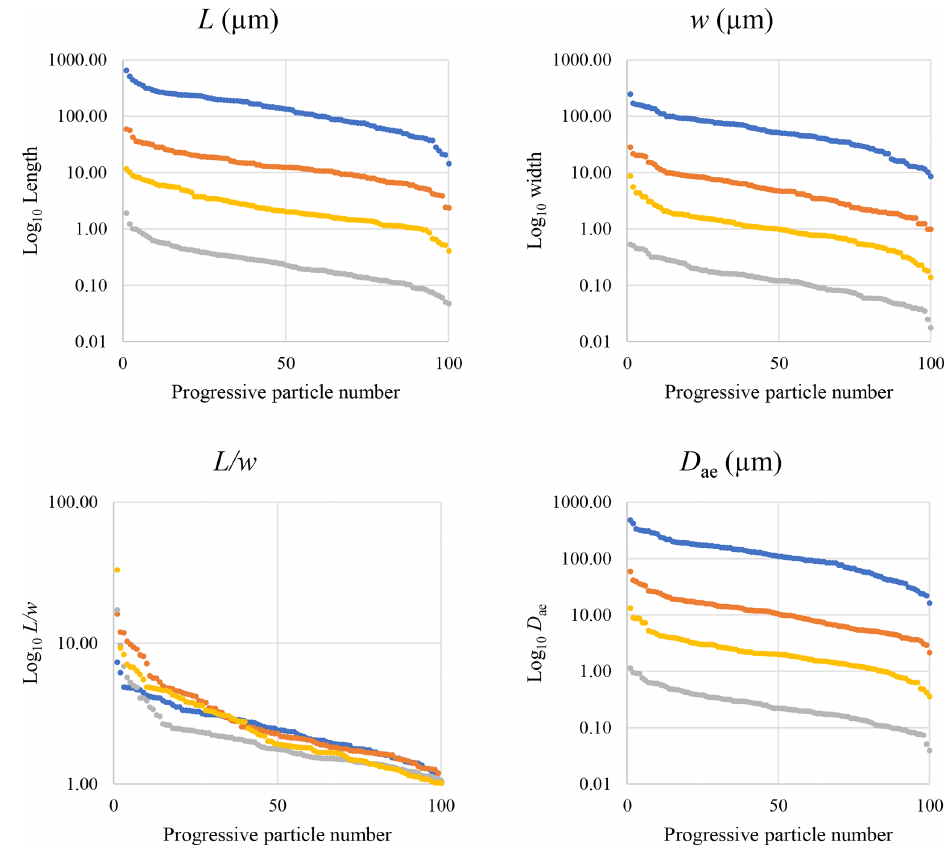
Figure 17. Plot of the dimensional data in descending order. Blue dots are particles measured by optical microscopy (10 × ), orange dots are particles measured with SEM (200 × ), yellow dots are particles measured with SEM (2000 × ), and grey dots represent particles measured by STEM (25000 ×